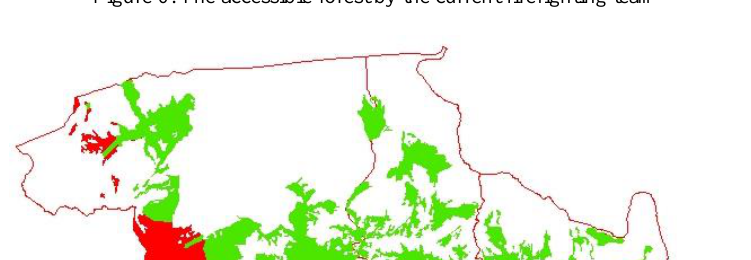
Figure 6. The accessible forest by the current firefighting team